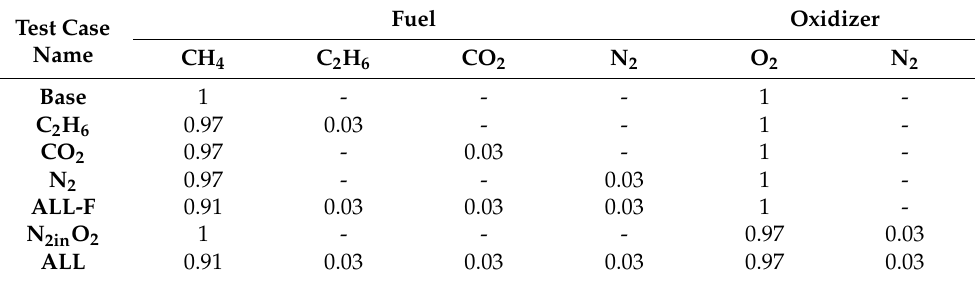
Table 4. Test-case composition overview (all compositions are in mole fraction). Test